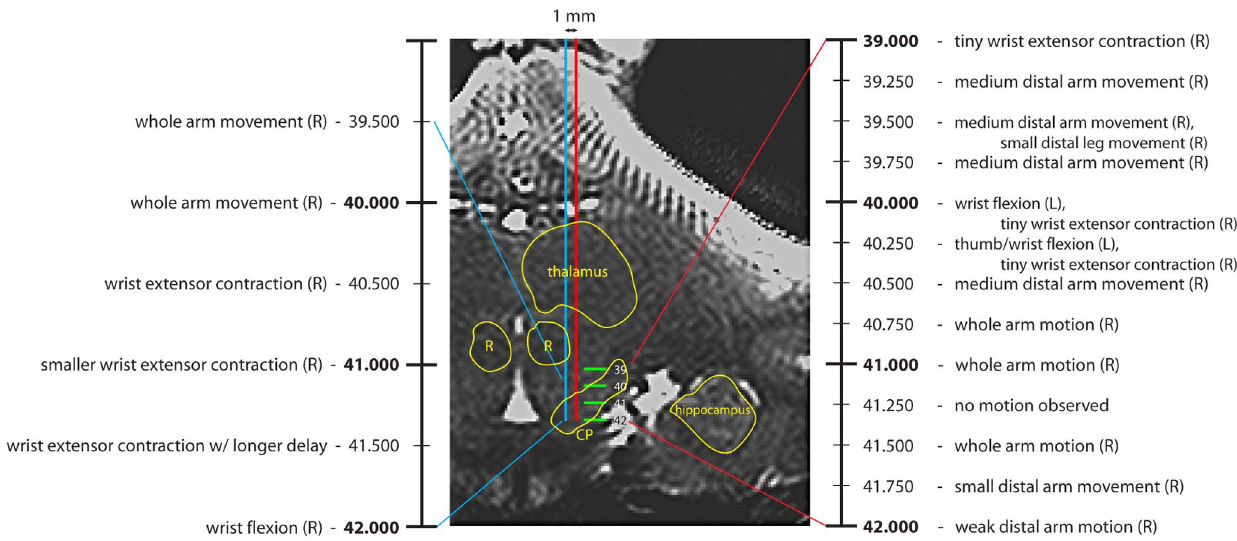
Figure 7. Microstimulation mapping of movements evoked near VTA/SNc. Microstimulation was used to map observed limb movements evoked along two tracks in Monkey N. 100 m A was used for the more medial track (ML 4.5), 50 m A was used 1 mm more laterally (ML 5.5) in the same AP ( + 9) plane. Stimulus trains were 100 ms at 300 PPS. Actual depths (below cortical surface) are denoted on the scan image. Expanded scales on the left and right indicate observed movements. All movements were brief and time-locked to the stimulation. Anatomical landmarks are outlined on the image (CP – cerebral peduncle; R – red nucleus).